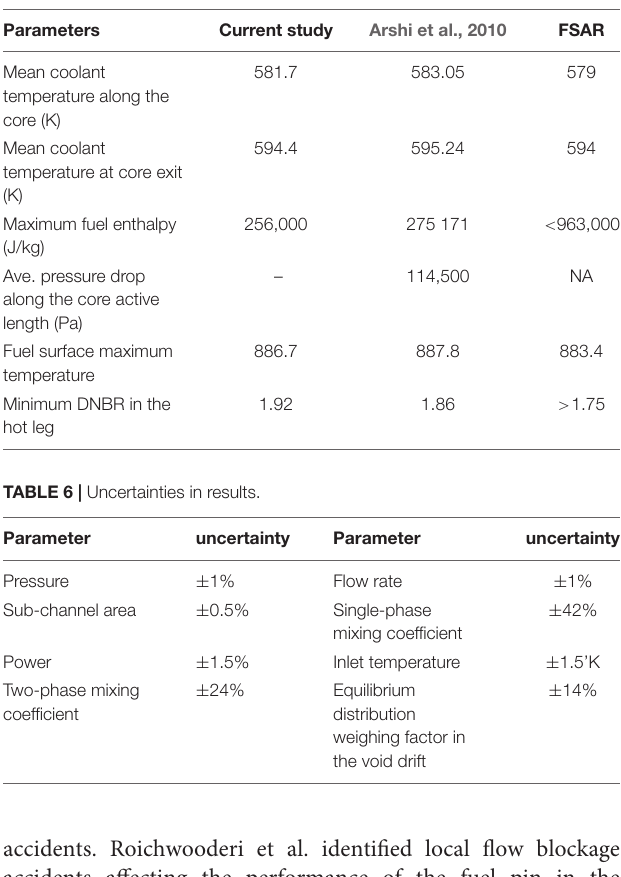
TABLE 5 | Validation of steady-state model.